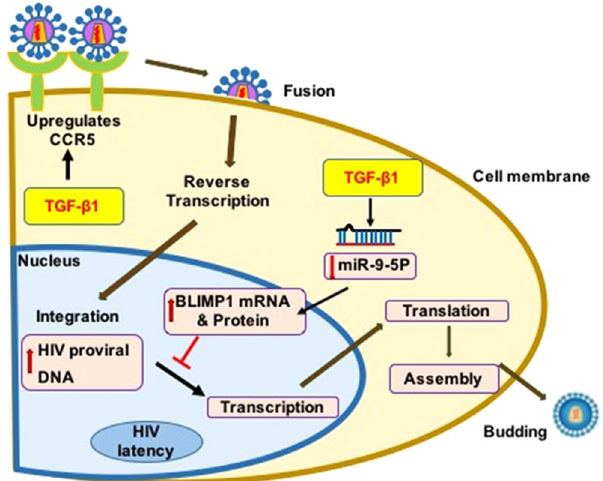
Figure 6. TGF- β 1 increases HIV reservoir load in the bronchial epithelium. Schematic representation of the effects of TGF- β 1 on host restriction factors to promote the HIV-1 reservoir load in human bronchial epithelial cells. TGF- β 1 increases levels of canonical HIV receptor CCR5. This increases infection of bronchial epithelium by R5-tropic HIV leading to an increased number of integrated HIV DNA. TGF- β 1 also suppresses miR-9-5p with a consequent upregulation of its target transcriptional repressor BLIMP-1. Together this leads to increased infection events and latency thereby increasing the viral load in the